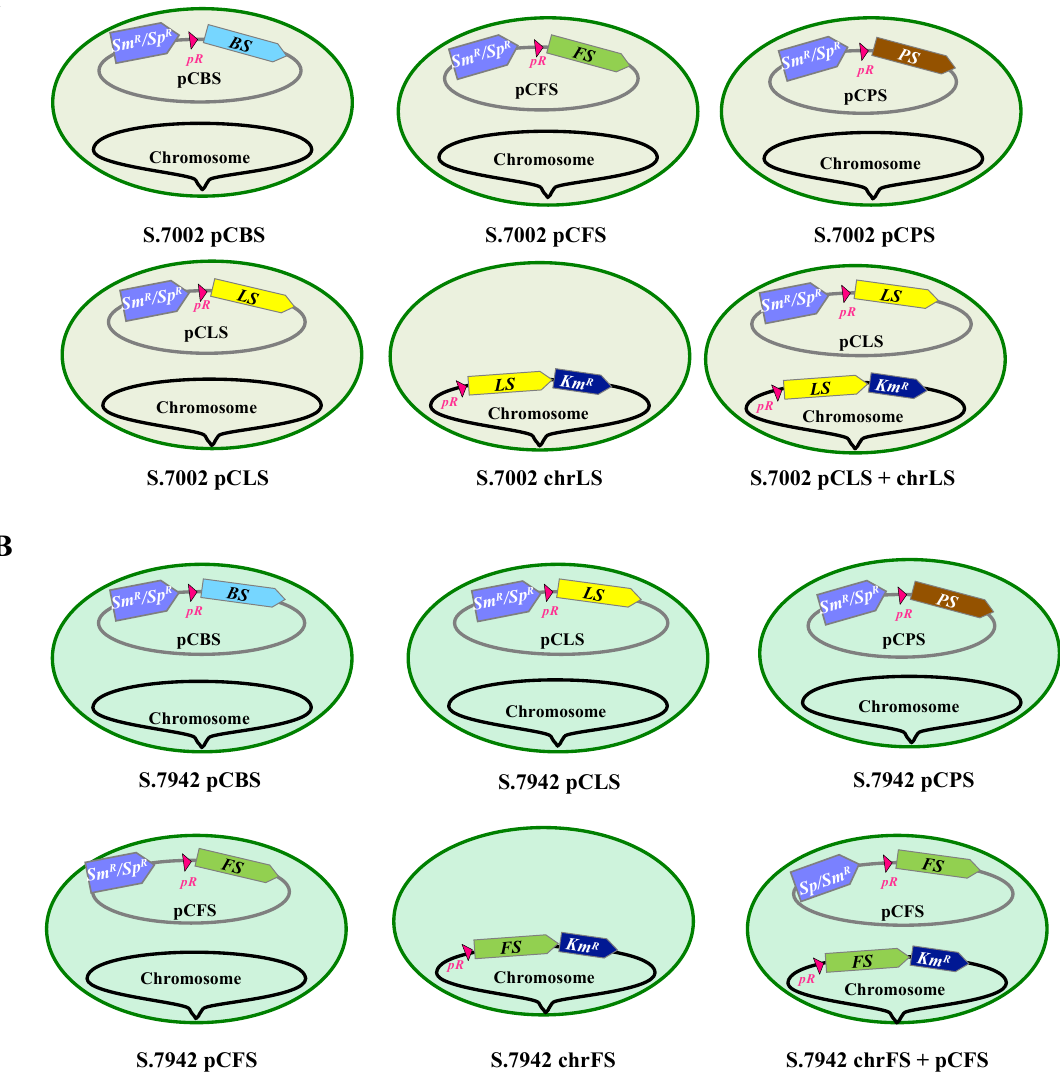
Figure 2. Schematic representation of the cyanobacterial strains engineered in this study. S.7002 ( A ) and S.7942 ( B ) cells are represented as green ovals, while their chromosome (black phylactery line) is arbitrarily shown as attached to the cell membrane to distinguish it from the pC-derived replicative plasmids. These Sm R /Sp R plasmids, which express a terpene-synthase encoding gene from the strong λ phage pR promoter (red triangle), are named pCBS (bisabolene synthase, light-blue arrow), pCFS (farnesene synthase, green arrow), pCLS (limonene synthase, yellow arrow) and pCPS (pinene synthase, brown arrow). Note that the chromosome of two strains of both S.7002 and S.7942 harbor a pR -LS (Km R ) and a pR -FS (Km R ) gene cassette, respectively. They served for the comparison of terpene production driven by either or both the replicating plasmid and the chromosome. The pR-LS and pR-FS recombinant genes were also cloned in the NS 7002 and NSI 7942 neutral chromosomal sites of S.7002 and S.7942, respectively, to compare the level of terpene production driven by either or both the plasmid and the chromosome (Figure